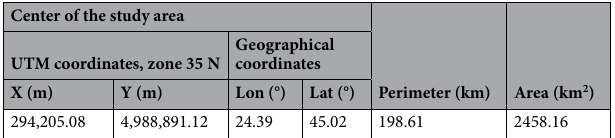
Table 1. Coordinates of the center of the study area.